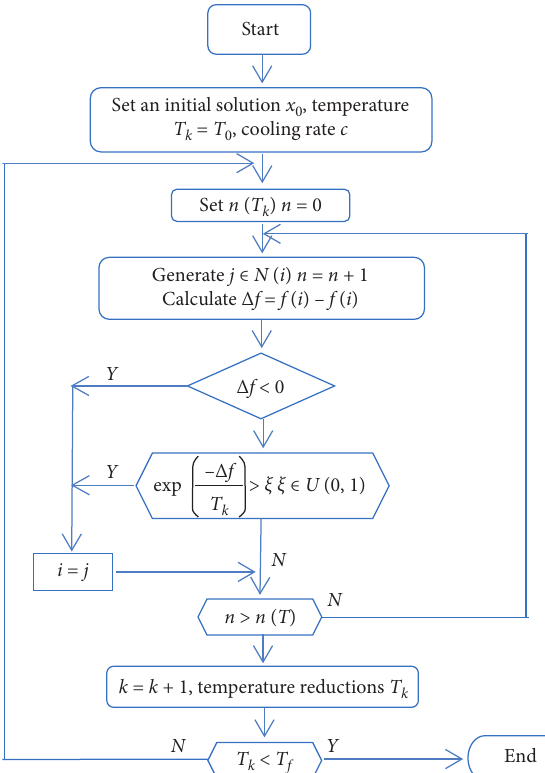
Figure 2: Simulated annealing algorithm flow chart.